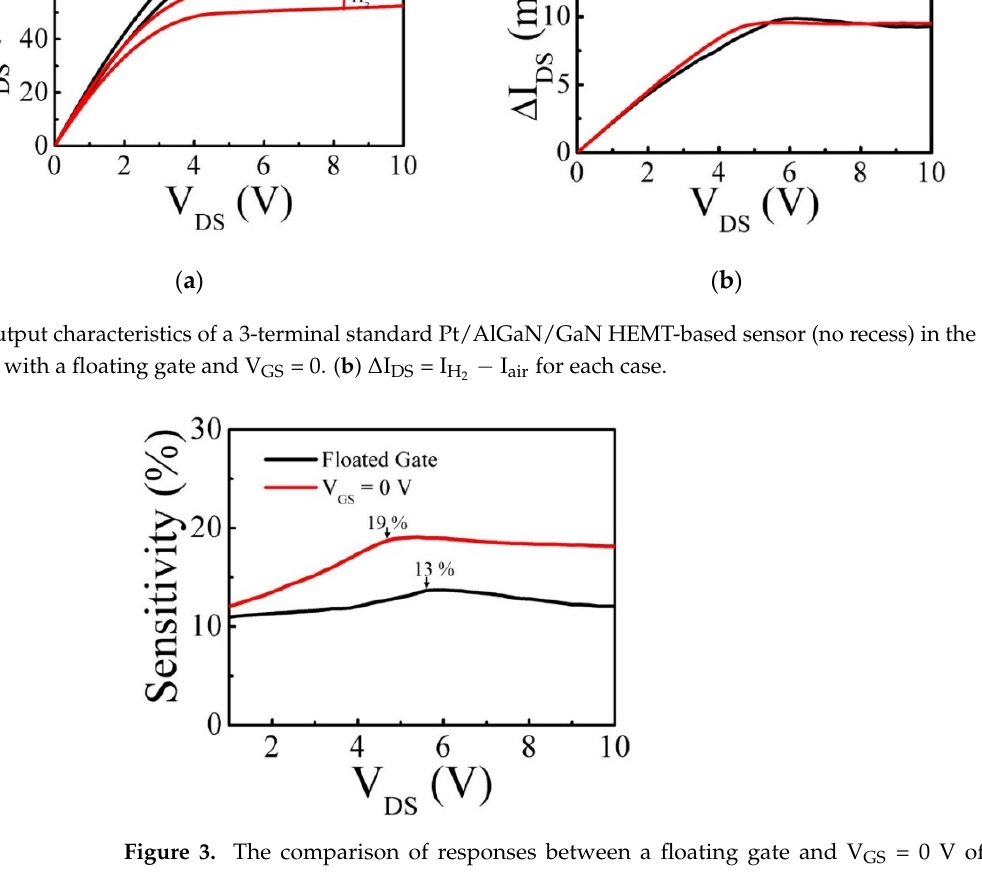
Figure 3. The comparison of responses between a floating gate and V GS = 0 V of a standard Pt/AlGaN/GaN HEMT-based sensor.